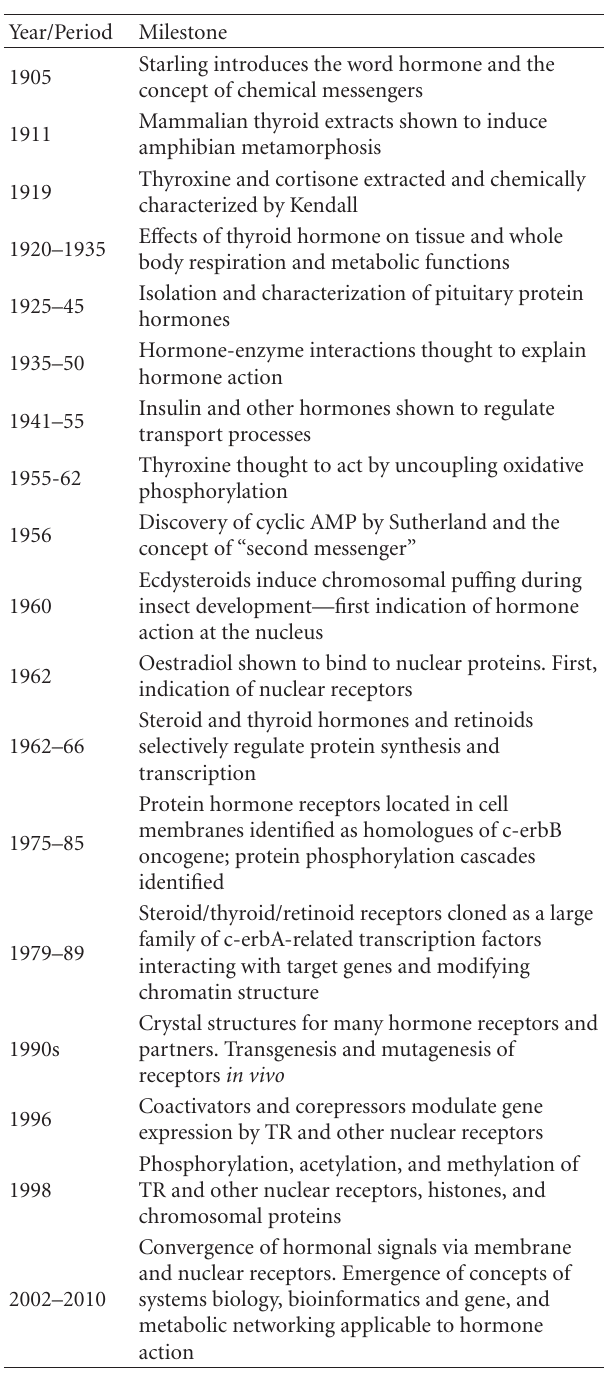
Table 3: Milestones in the search for mechanism of thyroid hormone